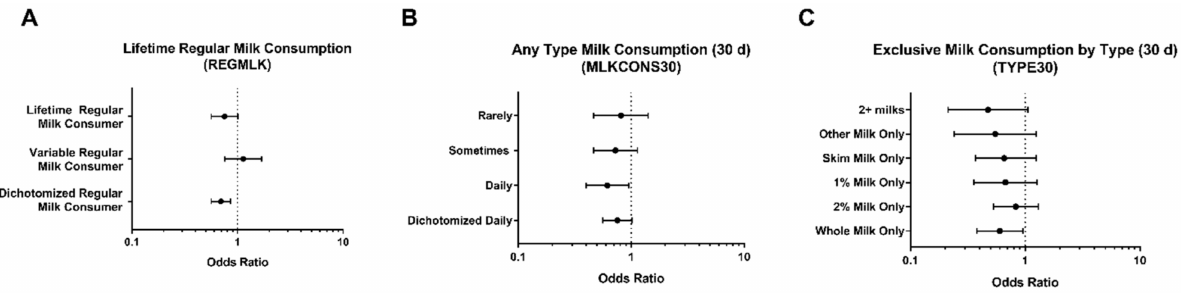
Figure 2. Associations between milk consumption tendencies and reporting current asthma in participants reporting asthma (history or current). Odds ratios for reporting current asthma amongst individuals reporting asthma based on identifying as ( A ) a lifetime regular milk drinker, or sometimes being a regular milk drinker across life as compared to identifying as never being a regular milk drinker; ( B ) based on any type of milk consumption tendencies in the previous 30 days; ( C ) based on regular (5+ days per week) exclusive type of milk